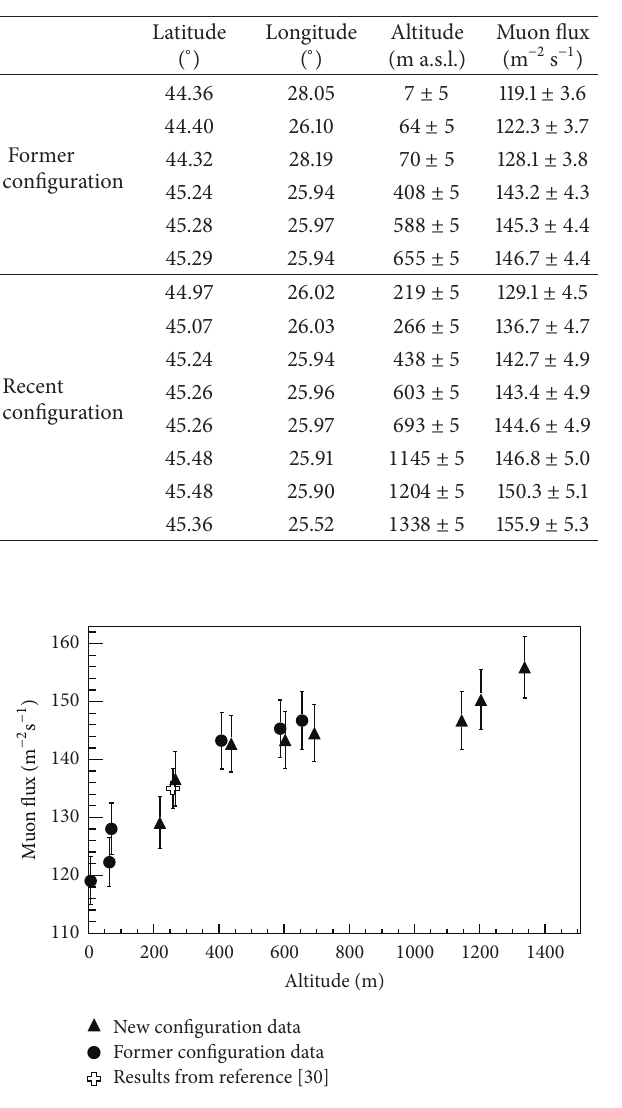
Figure 5: Measured results of the muon flux variation with altitude, obtained with both detector configurations of the active layers of the detector. The circles represent the data obtained with the former configuration. The data obtained with the new configuration is presented with triangles. The cross point represents the results from [30].